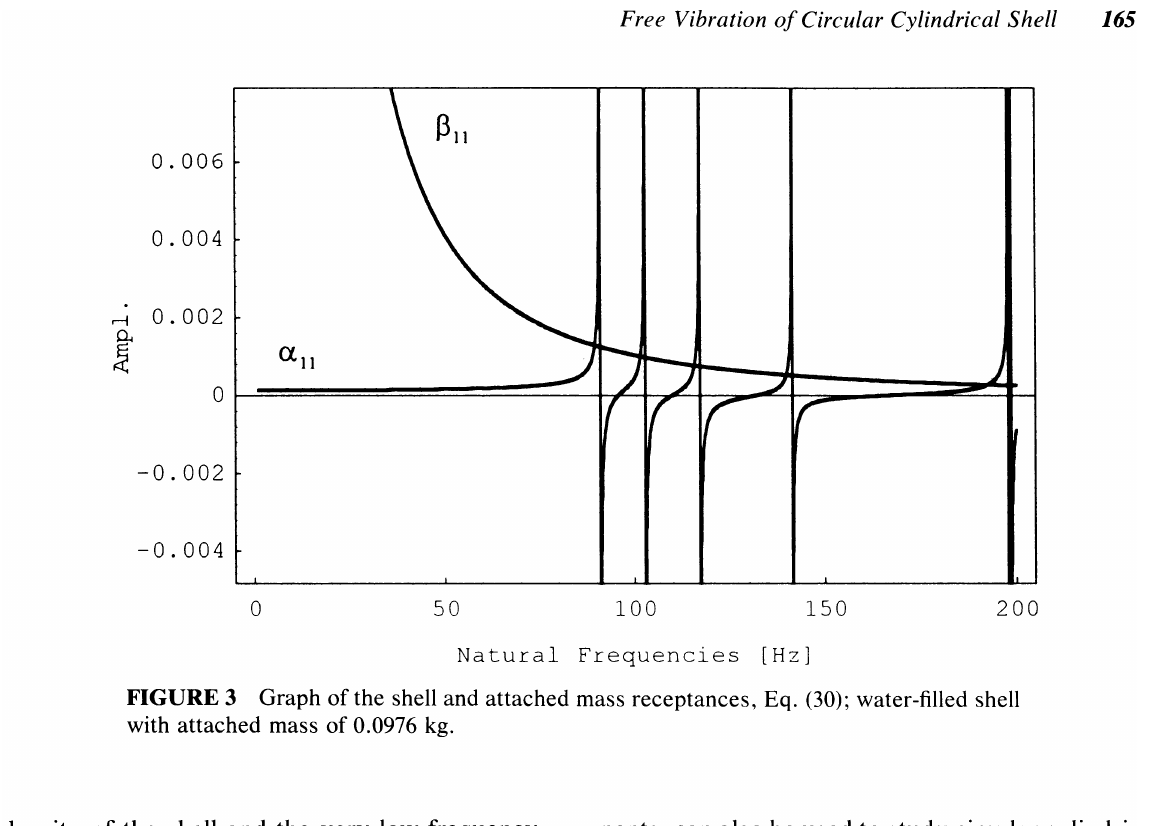
FIGURE 3 Graph of the shell and attached mass receptances, Eq. (30); water-filled shell with attached mass of 0.0976 kg.